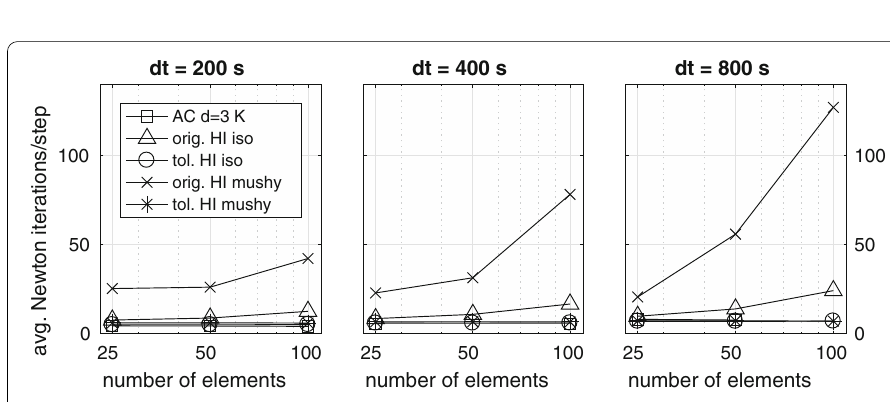
Fig. 12 Melting volume example: average number of iterations of all investigated methods for latent heat depending on spatial and temporal discretization